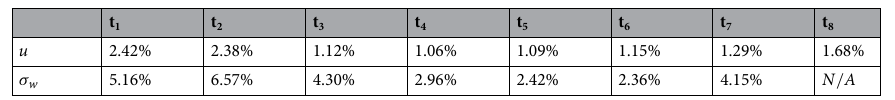
Table 3. Relative errors calculated by the same representative time instants as embedded in Fig. 7b. The average relative errors at the 8 time points are 1.53% for velocity and 3.98% for WSS. The analytical solution of σ w at t 8 tends to zero thus the relative error is not